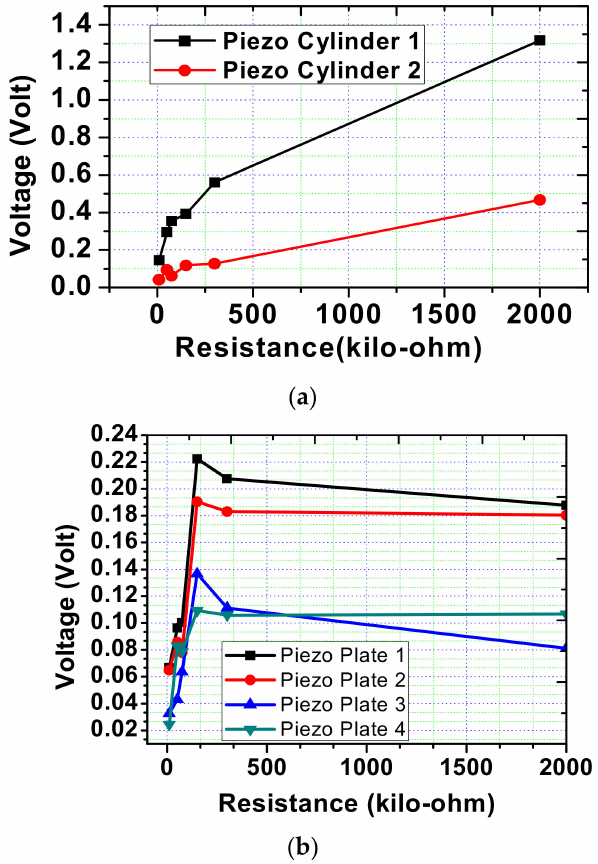
Figure 13. Dependence of the output voltage on the magnitude of the load. ( a ) Piezocylinders and ( b ) piezoplates.